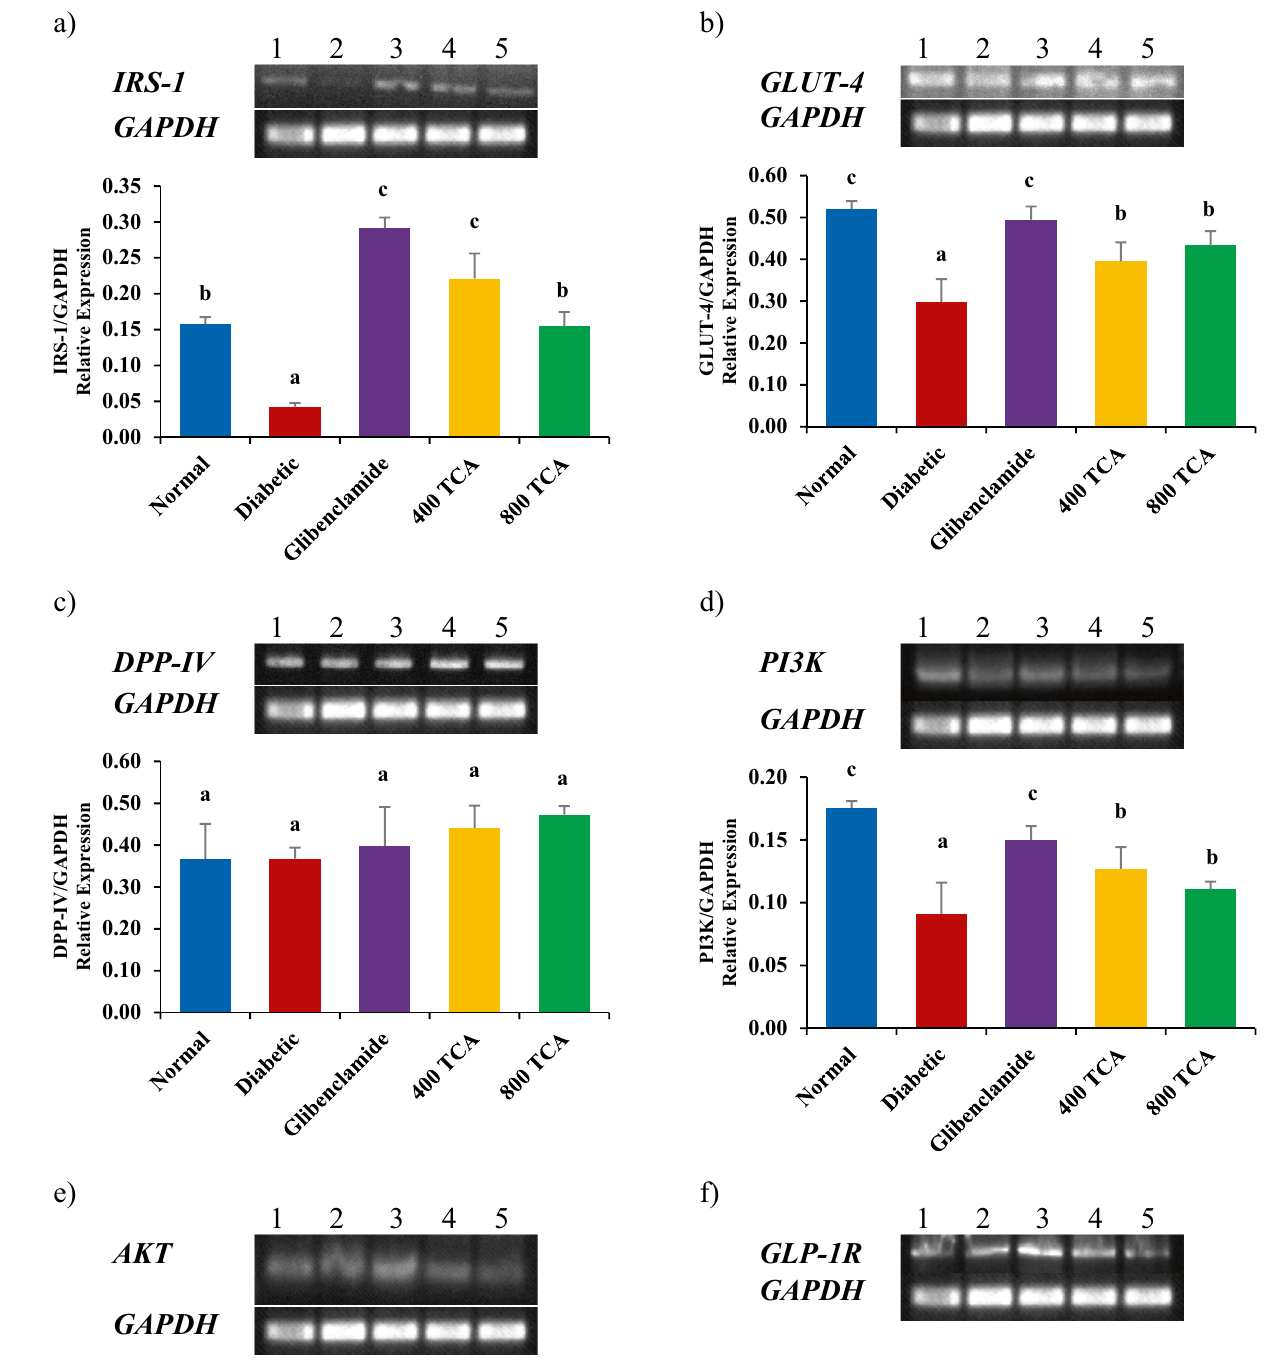
Figure 7. Effect of T. catappa aqueous extract treatment on hepatic ( a ) IRS-1 , ( b ) GLUT-4 , ( c ) DPP-IV , ( d ) PI3K , ( e ) AKT and ( f ) GLP-1R mRNA expression in HFD/STZ-induced diabetic rat. Bars are expressed as mean ± SEM (n = 6). Bars with different superscripts are significantly different, while those with similar superscripts are not significantly different at p <